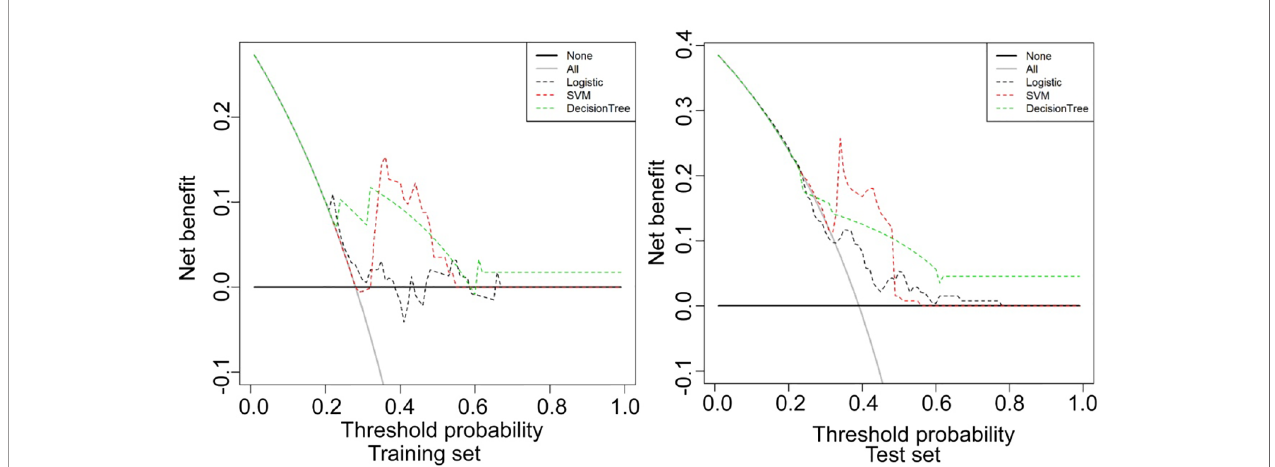
FIGURE 4 | Decision curve analysis (DCA) was conducted to evaluate the clinical usefulness of the models in prediction by quantifying the net bene fi ts at different threshold probabilities in the training and testing set. The SVM model had the best performance in prediction of low- and high-grade renal cell carcinoma. Logistic, logistic regression model; SVM, support vector machine model; Decision tree, decision tree model.